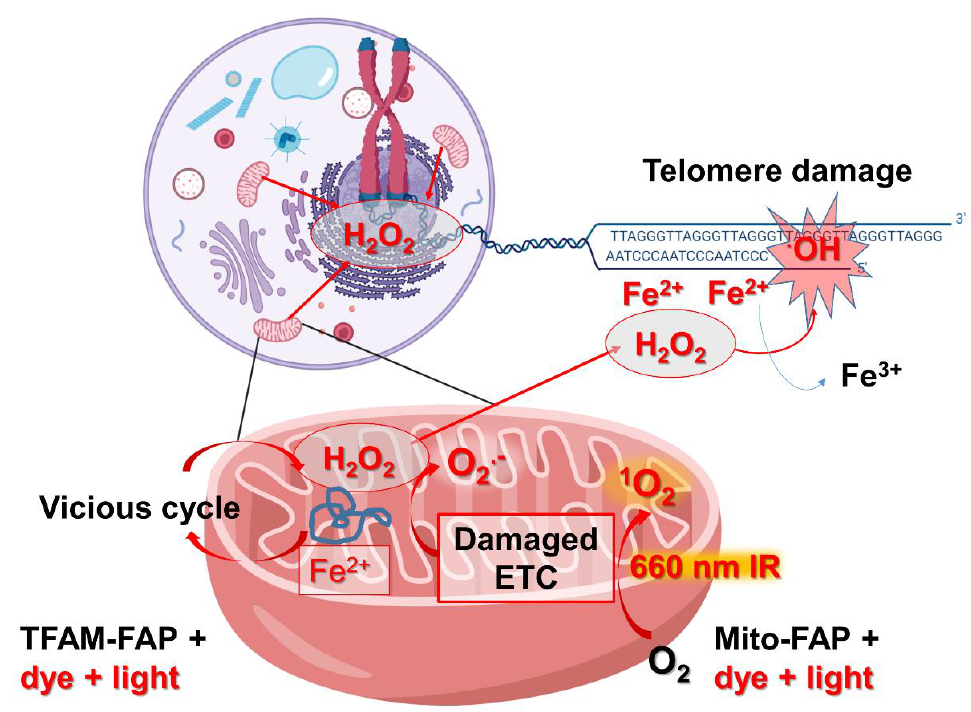
Figure 3. Dysfunctional mitochondria cause a vicious cycle of ROS production that preferentially damages mtDNA and telomeres. Upon binding to the MG2I dye and exposure to near-infrared light at 660 nm, Mito-FAP and TFAM-FAP generate singlet oxygen ( 1 O 2 ) with high quantum yield in close proximity to the electron transport chain (ETC) and the mtDNA, respectively. Oxidative damage to ETC components leads to a secondary wave of superoxide (O 2 ●− ), which is converted to H 2 O 2 by manganese superoxide dismutase (MnSOD). Likewise, persistent oxidative damage to mtDNA can lead to ETC dysfunction and eventual H 2 O 2 production within mitochondria. This H 2 O 2 can freely diffuse throughout the cell and can be converted to the highly reactive hydroxyl radical ( ● OH) via interaction with iron (Fe 2+ ) associated with the mitochondrial matrix or telomeric sequences, respectively. The hydroxyl radical can then damage mtDNA and telomeric sequences to lead to a vicious cycle of mitochondrial ROS production and premature aging, respectively.